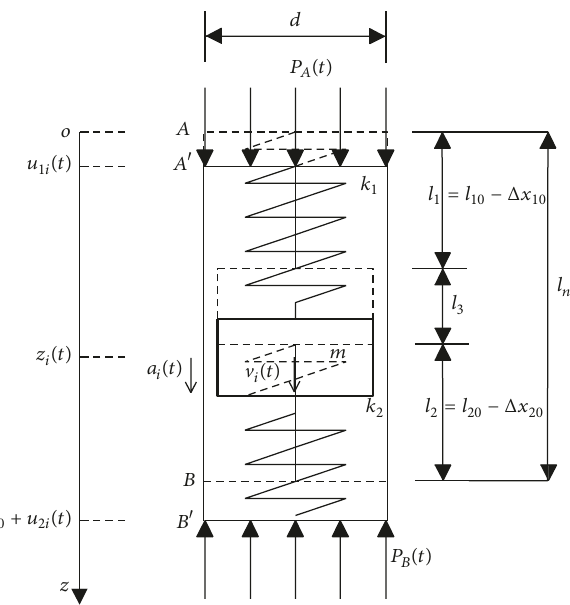
Figure 6: Deformation process of the wave